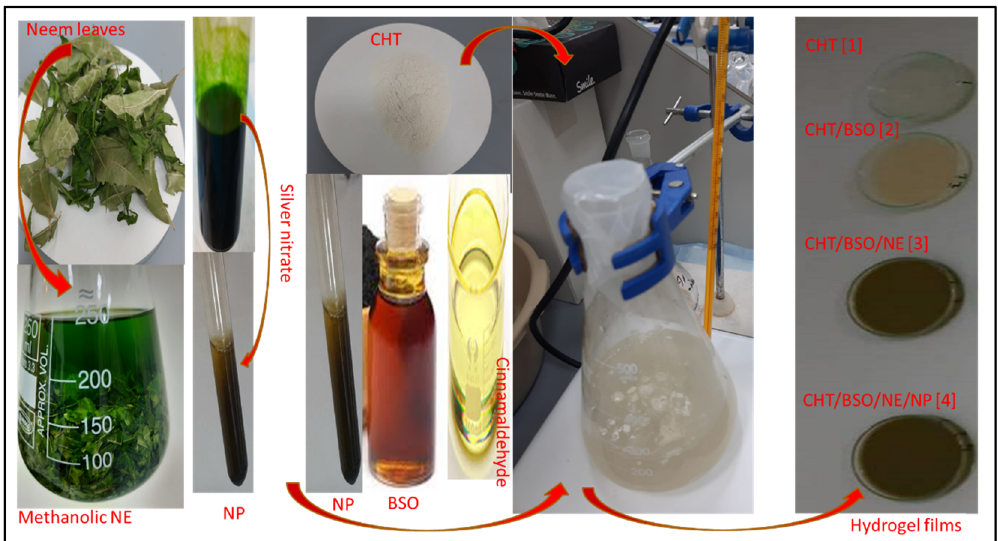
Figure 1: Synthesis of CH fi